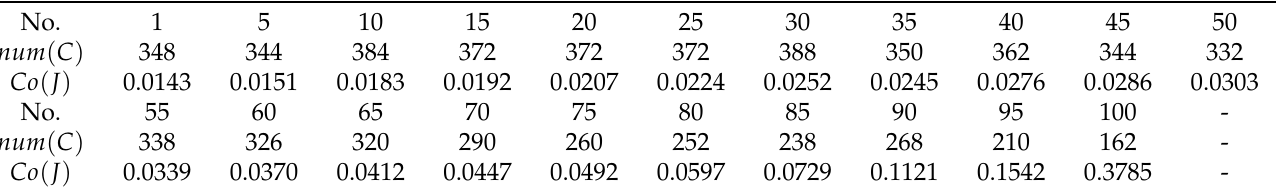
Table 2. num ( C ) and Co ( J ) in the interval AC .